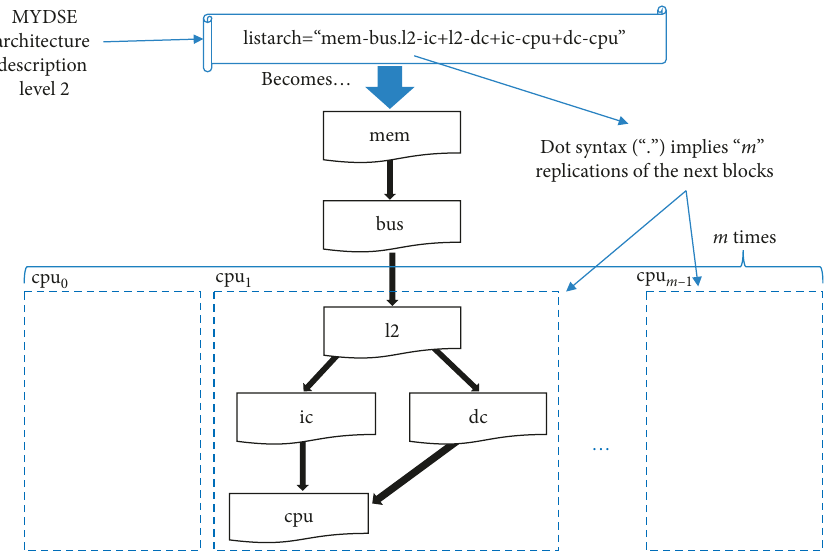
Figure 9: Level 2 architecture description of the cache model in COTSon by using the MYDSE toolset. In this design, the CPU is directly connected to both an Instruction Cache (“ic”) and a Data Cache (“dc”). The “ic” and “dc” caches are then connected to another level of caching, the L2 cache (“l2”), which is connected to the main memory (“mem”) through the Figure 9: i.e., the part “l2-ic + l2-dc + ic-cpu + dc-cpu” will be instantiated “ m ” times.